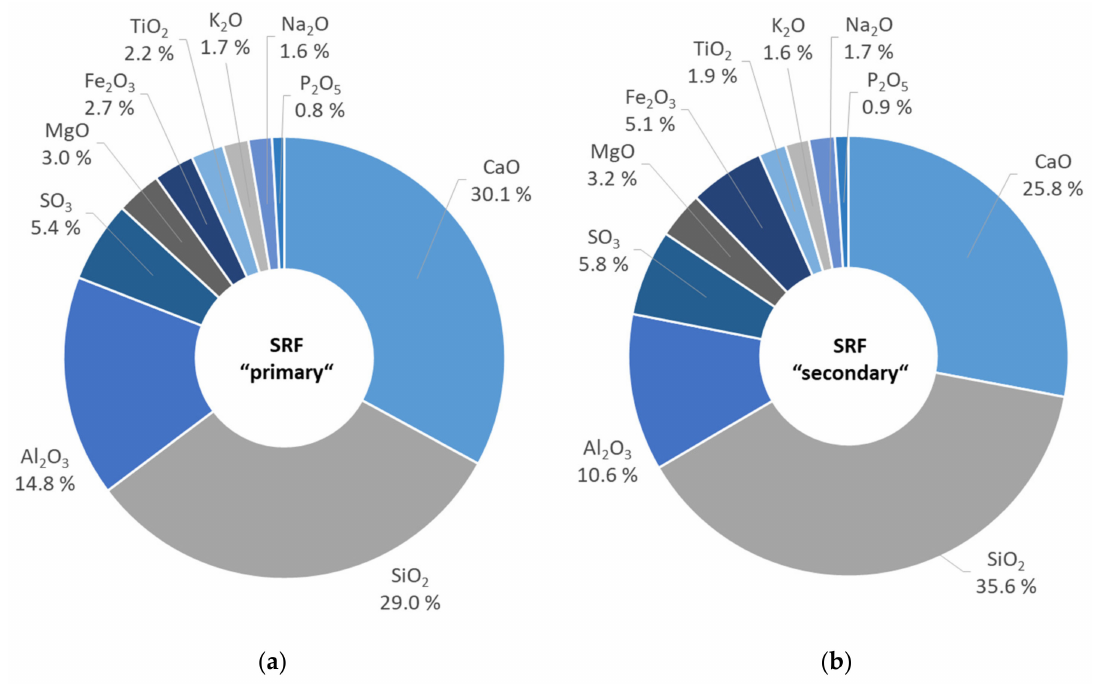
Figure 15. Average ash composition (arithmetic means) solid recovered fuel (SRF) primary ( a ) and secondary ( b ) in mass percent dry mass [53].